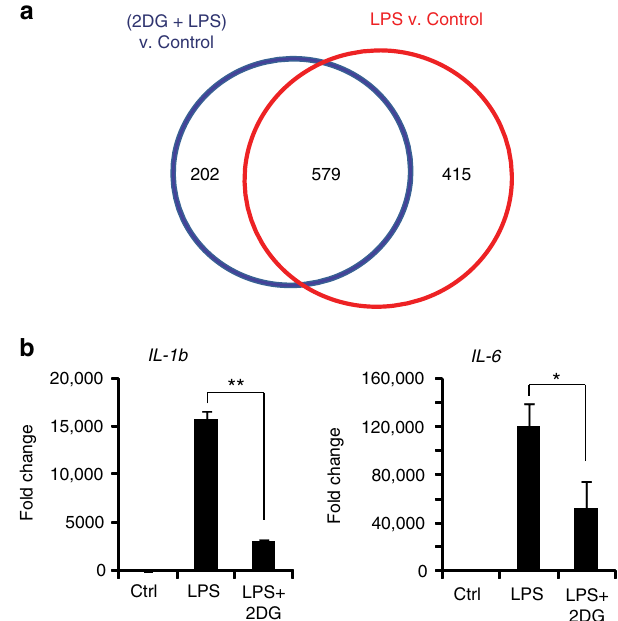
Fig. 4 LPS and 2-deoxyglucose in fl uence NF- κ B — mediated gene transcription. a Microarray analysis identi fi ed 994 genes differentially regulated by LPS ( red ) and 781 genes by (2DG+ LPS) ( blue ), relative to control conditions. 579 of LPS-response genes were affected by co-incubation with 2DG. b RT-PCR measures of NF- κ B – driven pro-in fl ammatory cytokines con fi rmed that LPS-induced induction was attenuated by 2DG. IL-1b , interleukin-1beta; IL-6 , interleukin-6. n ≥